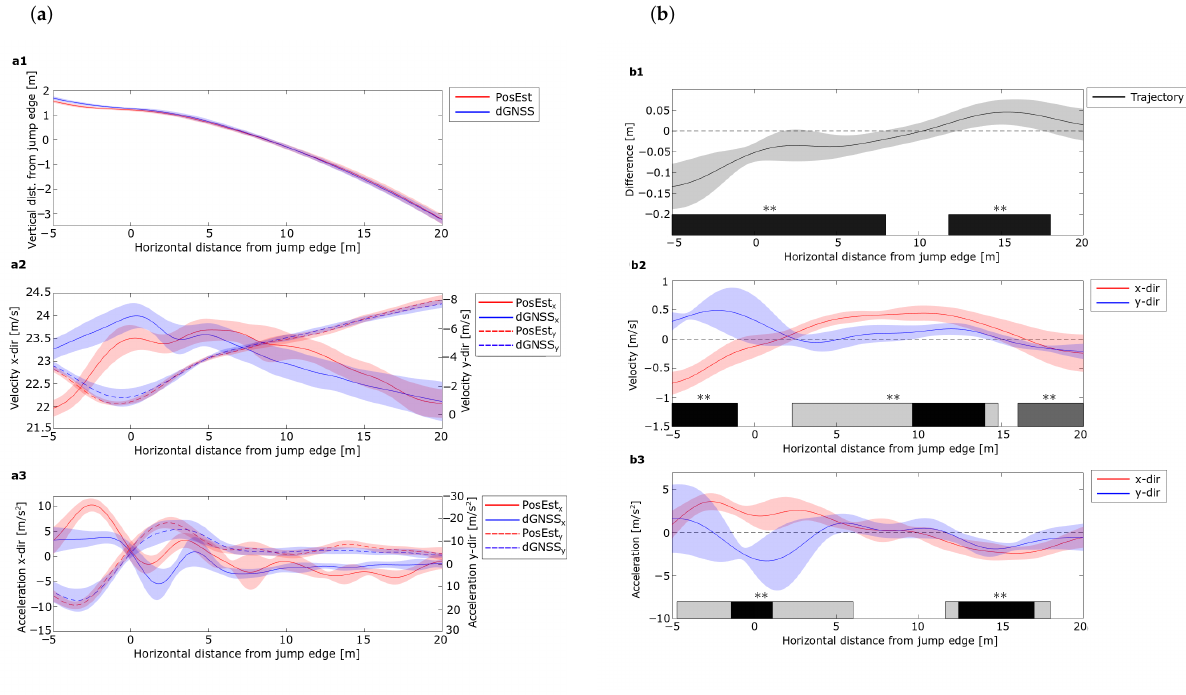
Figure 5. Comparison of data of the PosEst system and the dGNSS. ( a ) show the average trajectory ( a1 ), vertical and horizontal velocity ( a2 ) and acceleration ( a3 ). The shaded error bands indicate the standard deviation with n = 16. PosEst data are indicated in red and dGNSS in blue. ( b ) shows the average paired difference of the same variables between the systems. The shaded error bands indicate the standard deviation with n = 16 and the dashed line zero difference. The paired differences in the x-direction are indicated in red and in the y-direction in blue. The SPM statistical information is represented by the horizontal bars for the paired difference. The black bar represents the statistical difference between the paired difference and zero in ( b1 ). In ( b2 , b3 ), the light gray color represents statistical difference in the x-direction, dark gray in the y-direction and black in both directions, where ** denotes p <